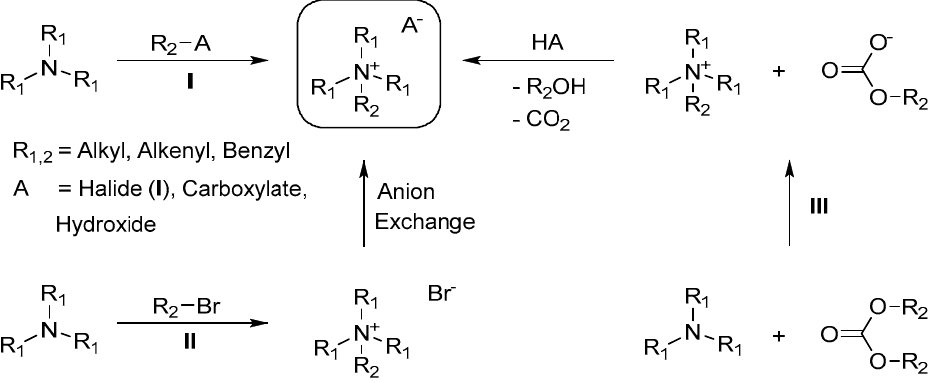
Scheme 1. Synthesis of quaternary ammonium electrolytes by quaternization of tertiary amines with organic halides ( I , II ) or dialkyl carbonates ( III